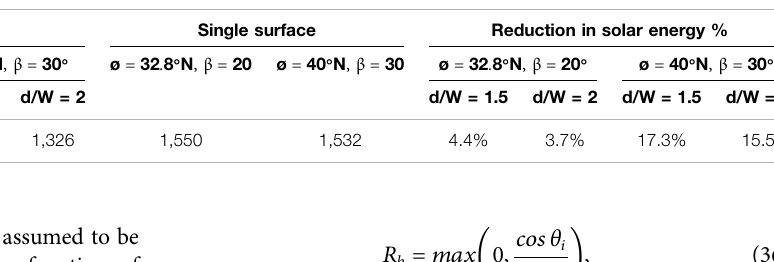
TABLE 3 | Daily solar radiation [W/m 2 /day] incident on the solar PV fi eld and the single surface, shading conditions ( ∀ A Transposition model Solar PV fi eld Single surface